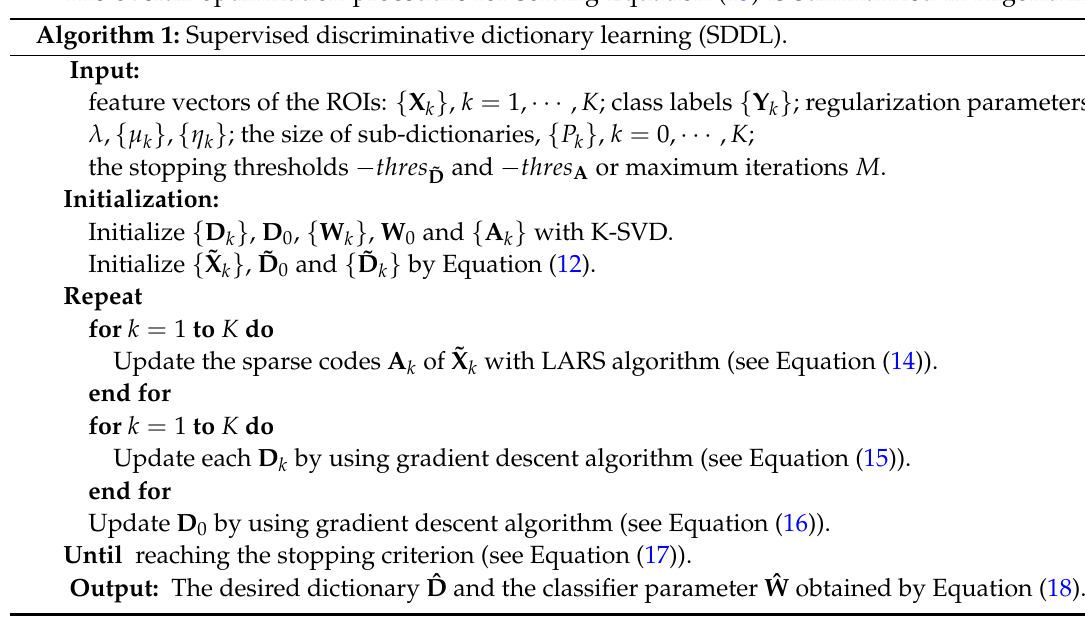
Algorithm 1: Supervised discriminative dictionary learning (SDDL).